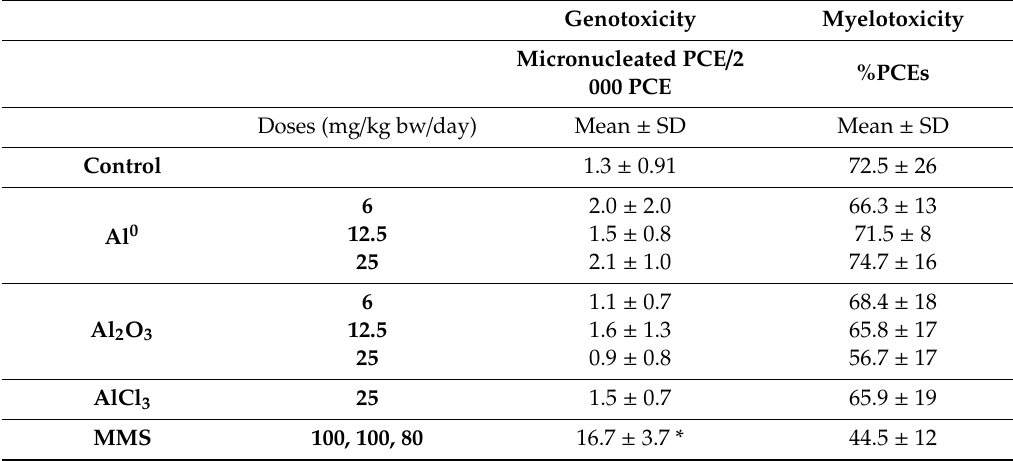
Table 2. Genotoxicity of Al 0 NMs, Al 2 O 3 NMs and AlCl 3 in rats treated orally detected by the micronucleus assay in bone marrow.